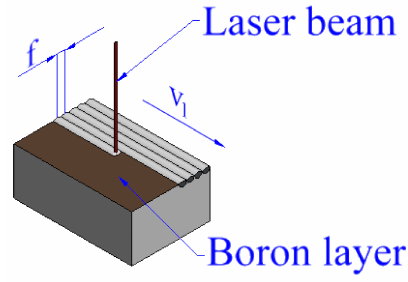
Figure 1. Scheme of the laser boriding